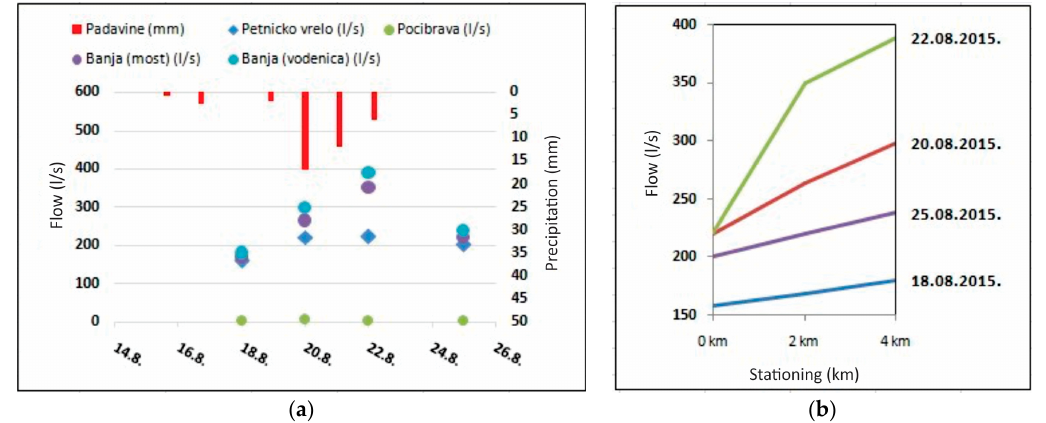
Figure 4. ( a ) Results of river regime monitoring and precipitation for research period; ( b ) Dependence between flow and stations for the research period.